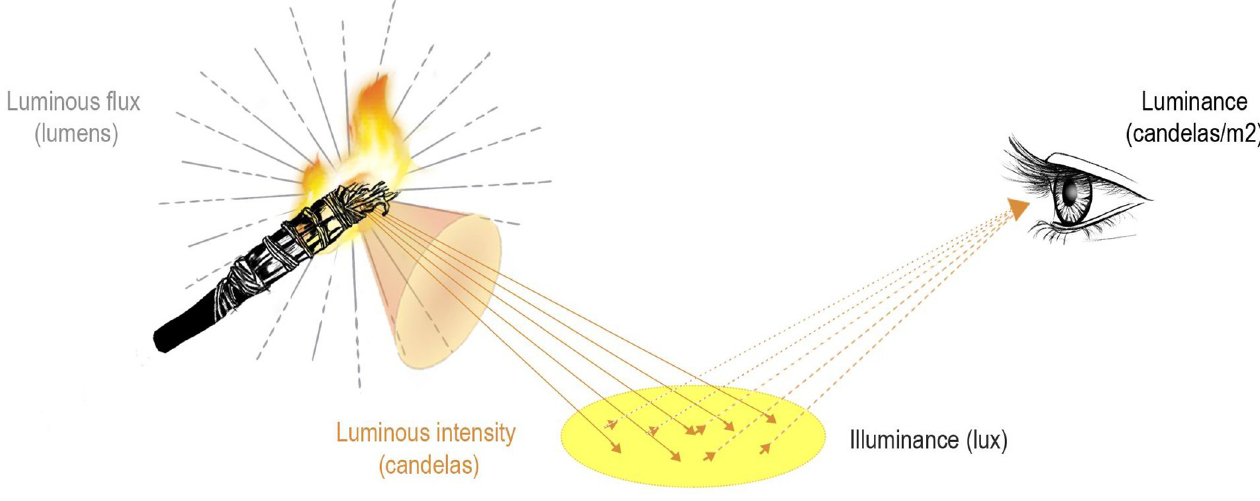
Fig 5. Scheme of the measured